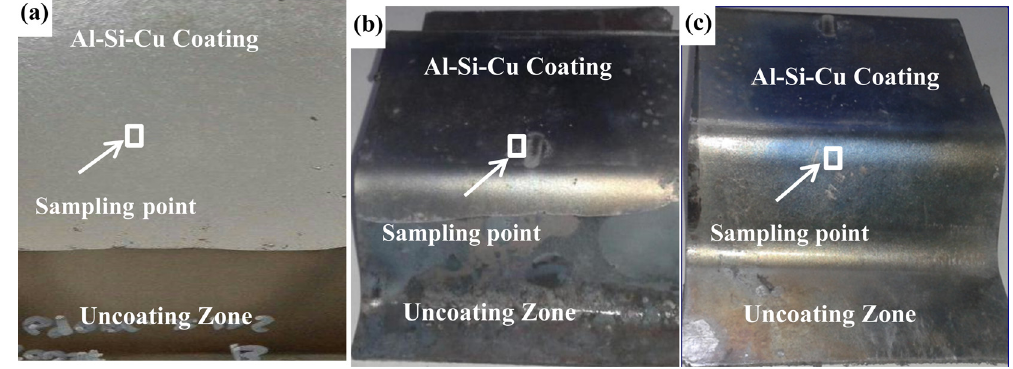
Figure 3: Morphology of coatings: ( a ) hot - dip coating, ( b ) hot stamping coating with forming radius of 2 mm, and ( c ) hot stamping coating with forming radius of 4